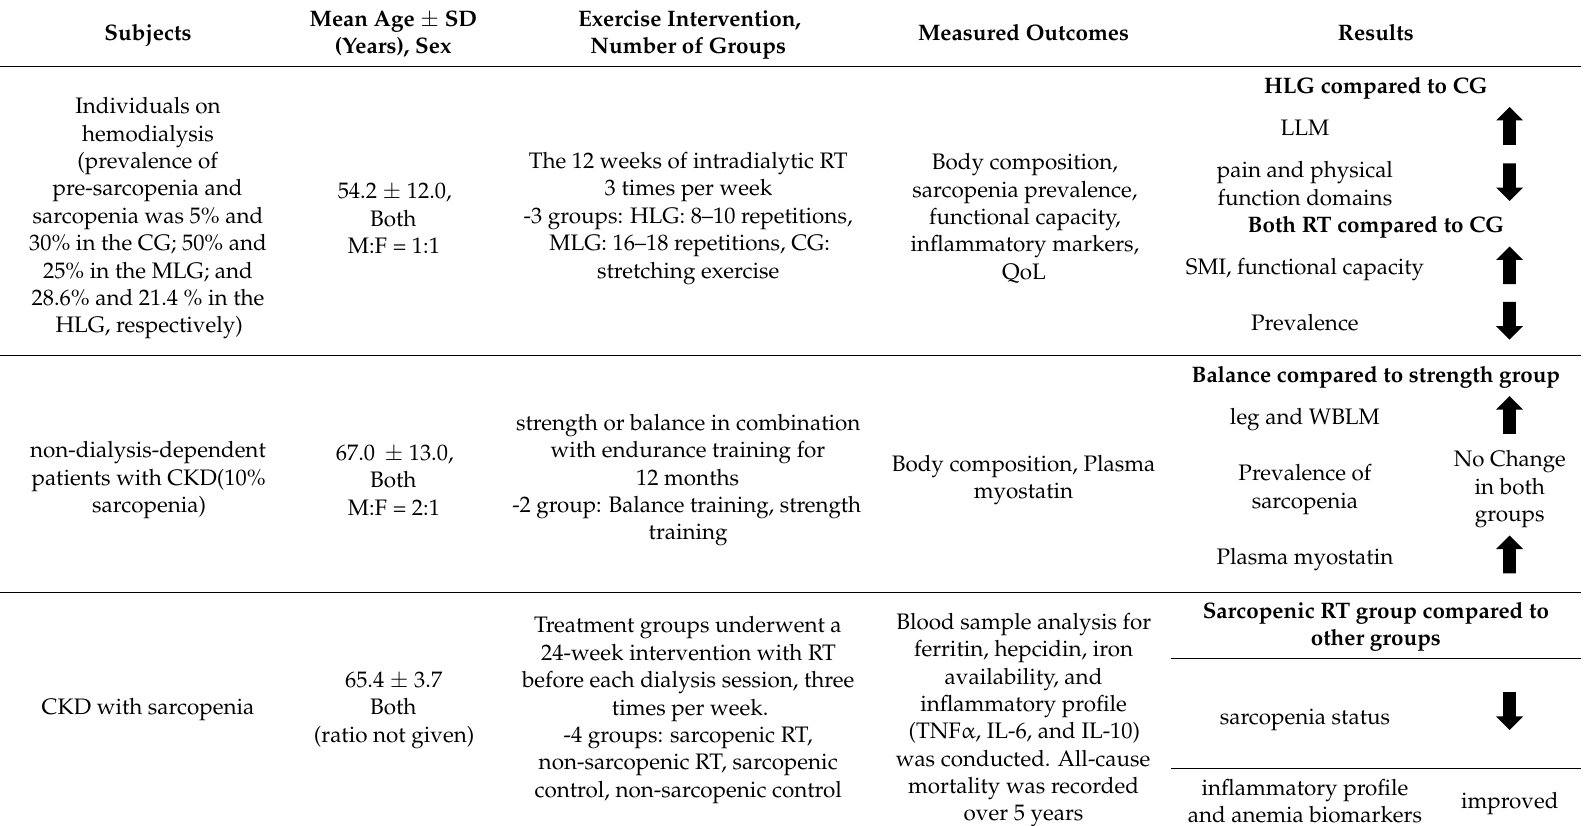
Table 1. Effect of exercise on subjects with cancer and baseline measurement of sarcopenia.